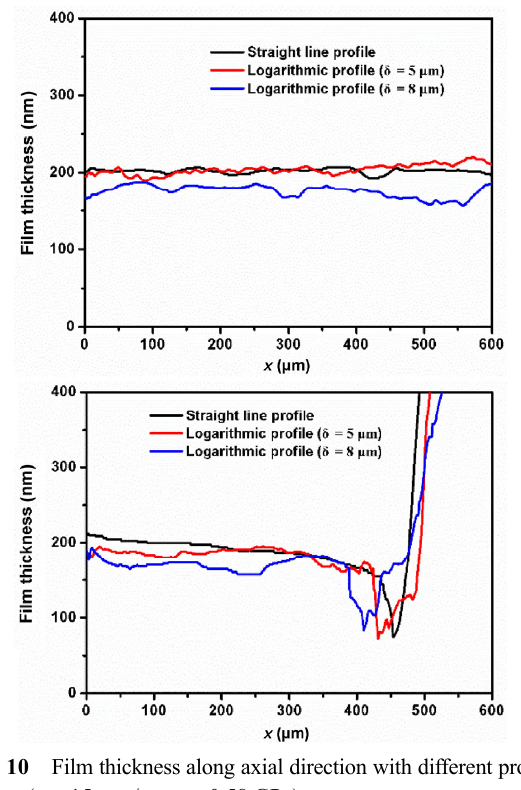
Fig. 10 Film thickness along axial direction with different profile rollers ( u = 15 mm/s, p max =0.58 GPa).